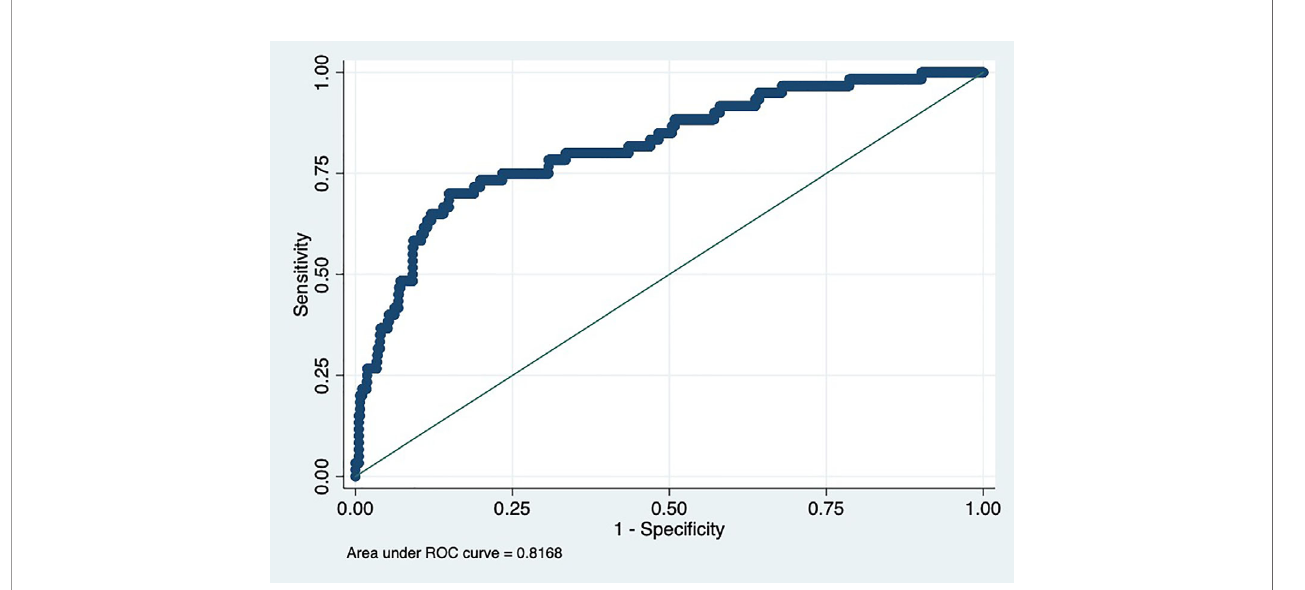
FIGURE 1 | Receiver operating characteristic (ROC) for predictive values of C1q levels in detecting metabolic syndrome